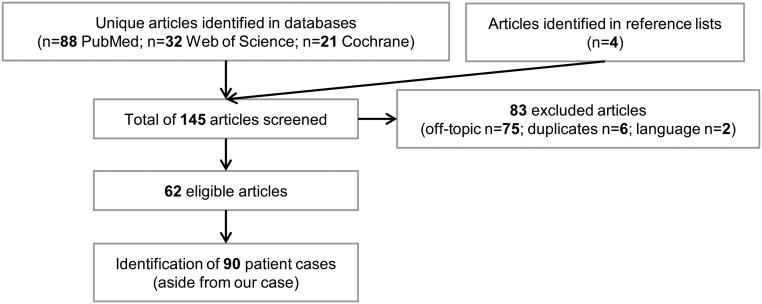
Flow chart of study selection.